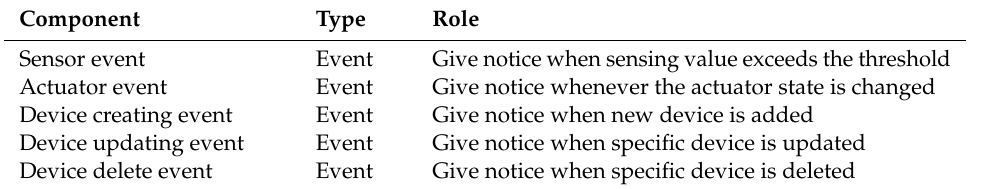
Table 6. Sample event definition in the smart contract.